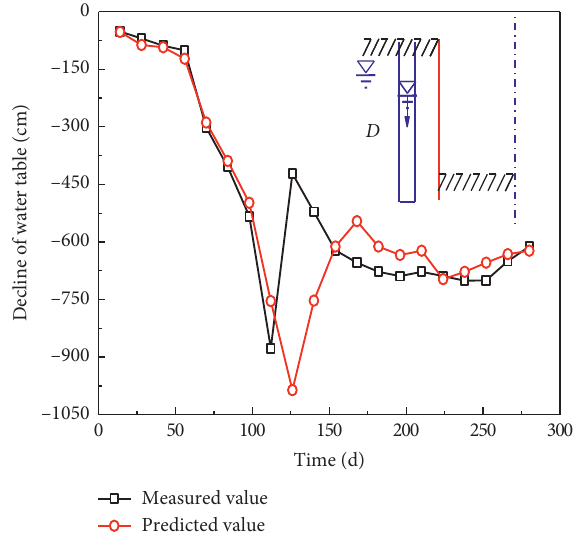
Figure 11: Minimum variation curve of groundwater